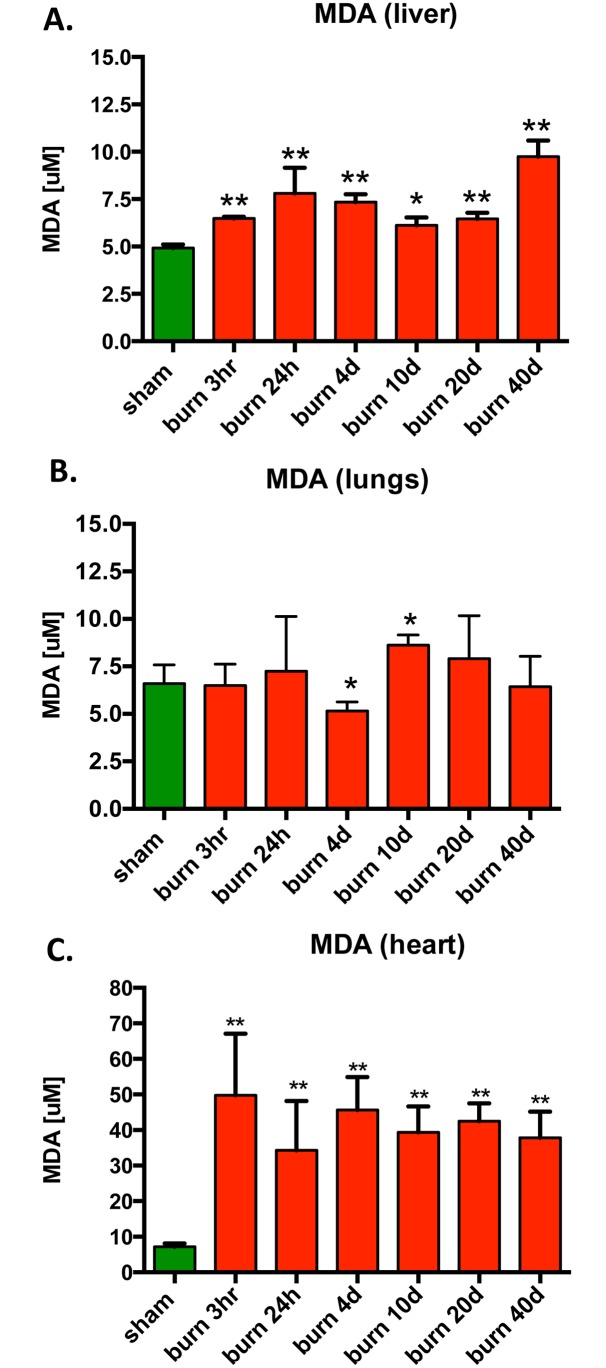
Changes in MDA, an index of lipid peroxidation, in response to burn injury.MDA levels were measured in (A) liver, (B) lungs and (C) heart of mice subjected to burn injury. The results are based on n = 6 per group and represent mean±SD. *, ** p<0.05 and p<0.01 respectively, relatively to sham animals.